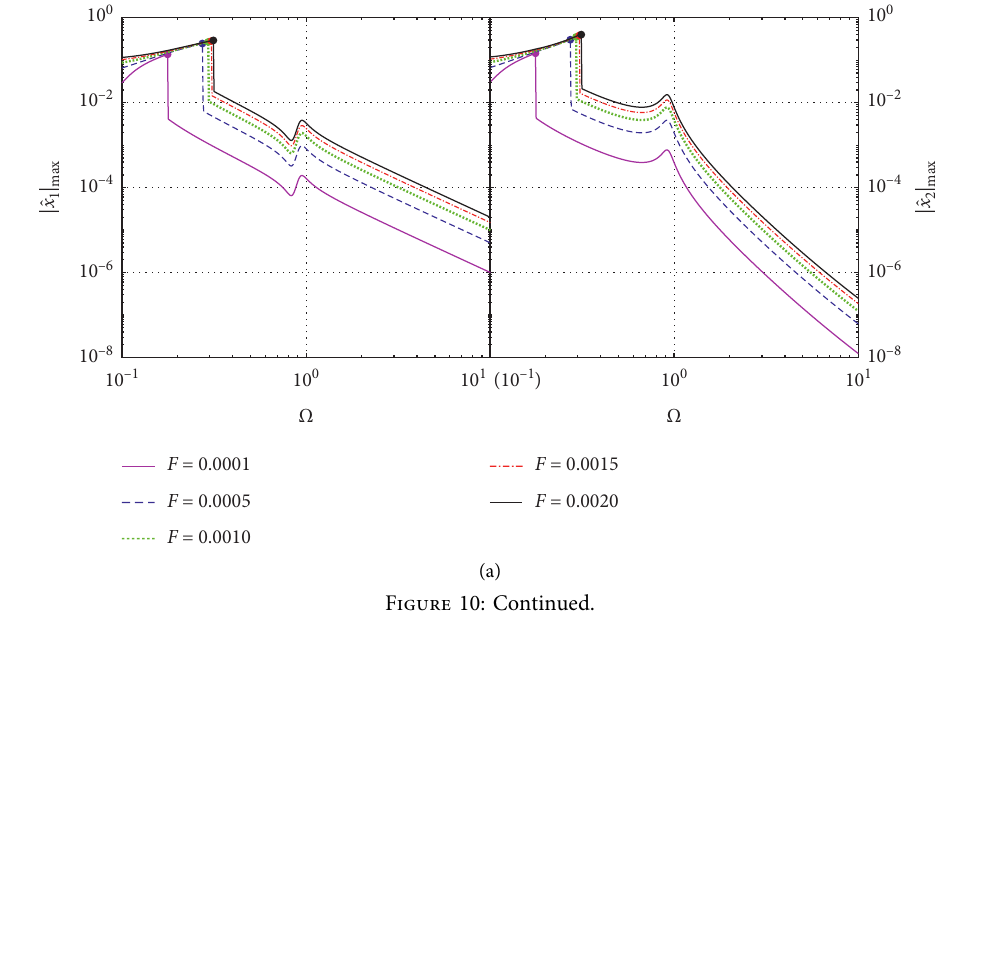
� 0 . 5, and the corresponding free periodic h 1 ( 􏽢 x , _ 􏽢 x ) and η ( η , _ η ) , respectively. The parameters set in the numerical solution 2 1 1 2 1 1 � ϕ